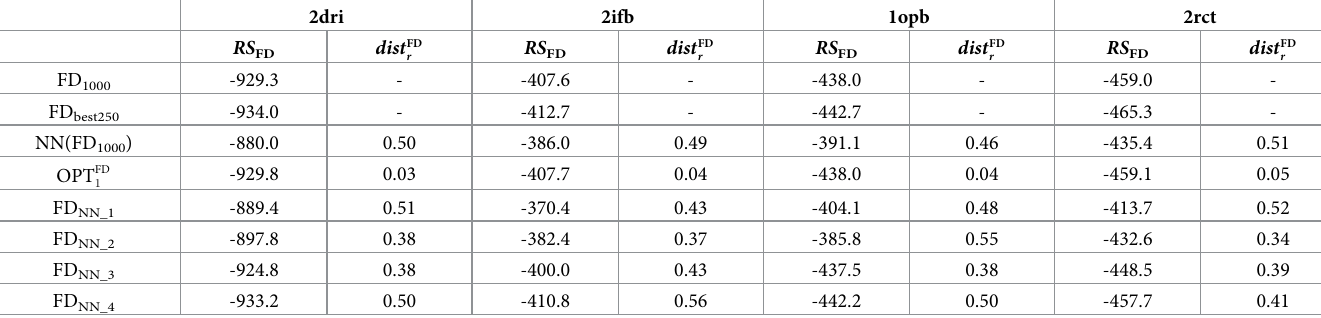
Table 2. Performance of FastDesign and a protocol based on four iterations of NN training.